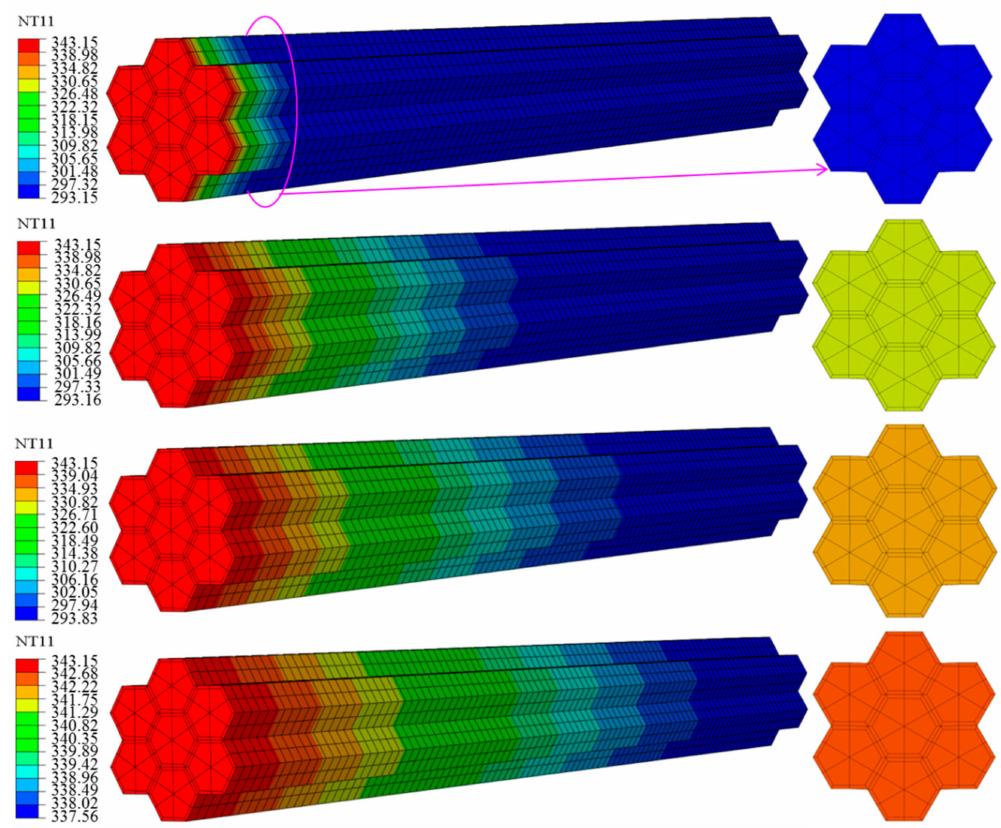
Figure 14. Temperature field distributions for longitudinal heat transfer.